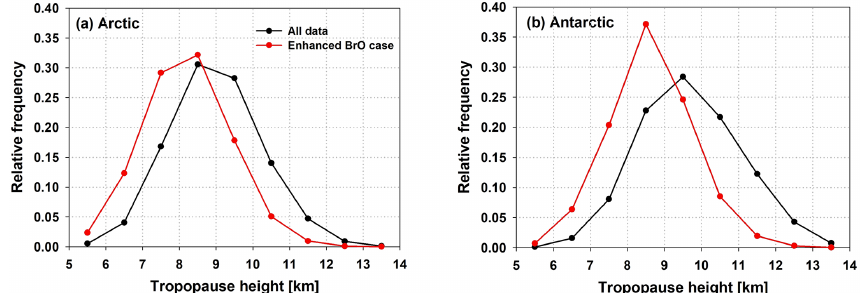
Figure 17. Frequency distribution of tropopause height for all data (black line) and the enhanced BrO case (red line) in (a) the Arctic and (b) Antarctic sea ice regions in spring (Arctic: March to April; Antarctic: September to October).